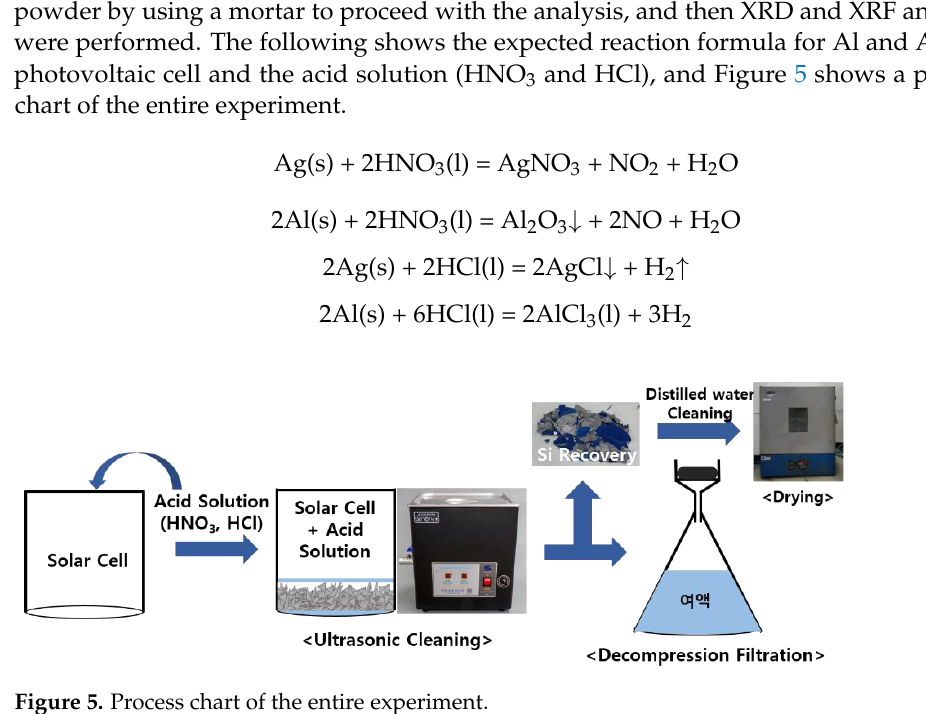
Figure 5. Process chart of the entire experiment.